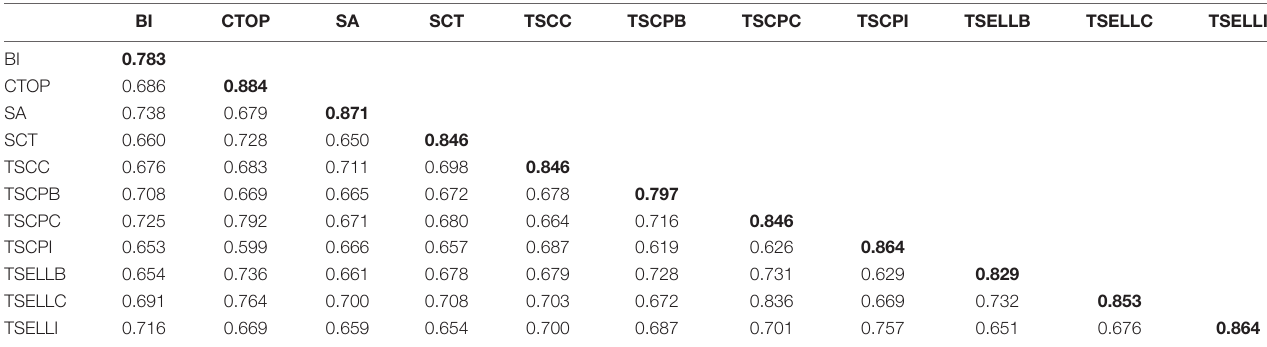
TABLE 3 | Constructs correlation and square roots of AVE values.